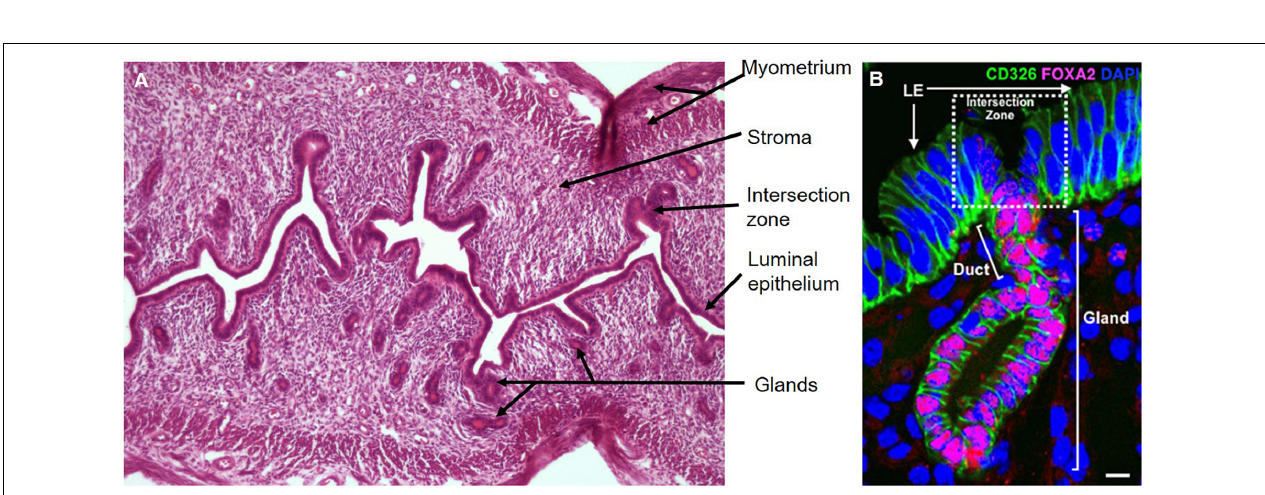
FIGURE 3 | Mouse endometrium and epithelial unit. (A) Longitudinal section of estrous cycling endometrium, hematoxylin, and eosin stained. (B) A representative uterine epithelial unit stained with CD326 (EpCAM, epithelial marker, green) is composed of LE, duct and single gland labeled by FOXA2 (red) in adult wild-type uterine tissue section. The dotted line shows the intersection zone between luminal and gland epithelial compartments. Scale bar: 5 µ m.